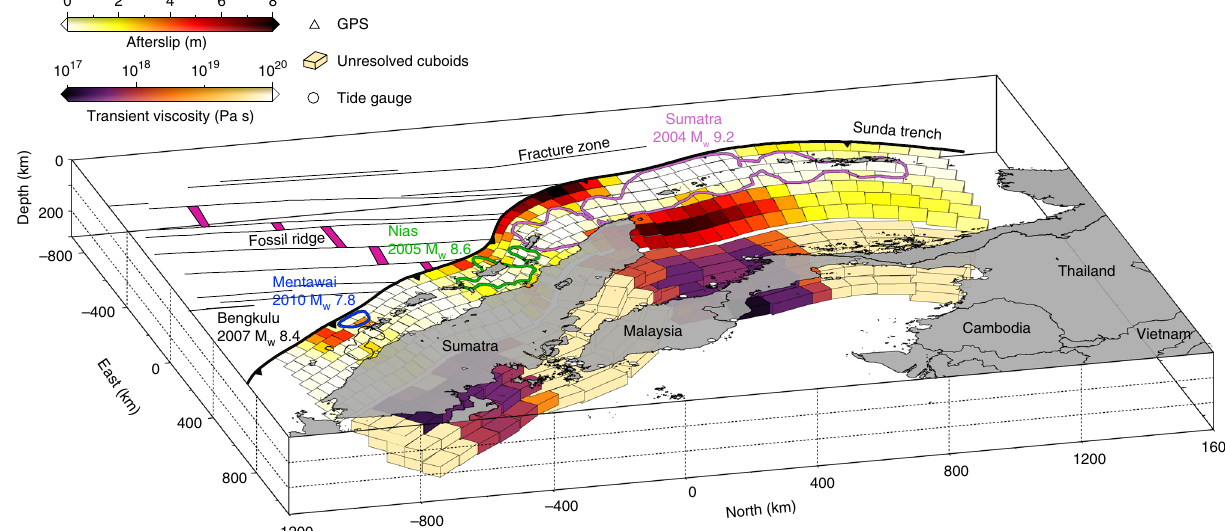
Fig. 7 A 3D view of the cumulative afterslip surrounding the coseismic rupture areas from 2005 to 2014. Transient effective viscosities immediately following megathrust earthquakes along the Sumatran subduction zone. Coloured contours are the same as Figs. 1a, 3a and 6a,b, with the name and magnitude of earthquakes labelled the same colour code. Colour bars indicate the afterslip and transient effective viscosity, respectively. Coloured patches and cuboids are the 3D presentation of megathrust and discretised mantle wedge at this region. Unresolved cuboids are labelled as light orange colour. Subducting sea fl oor structures, fracture zone and fossil ridge are represented as light black lines and magenta shaded areas, respectively